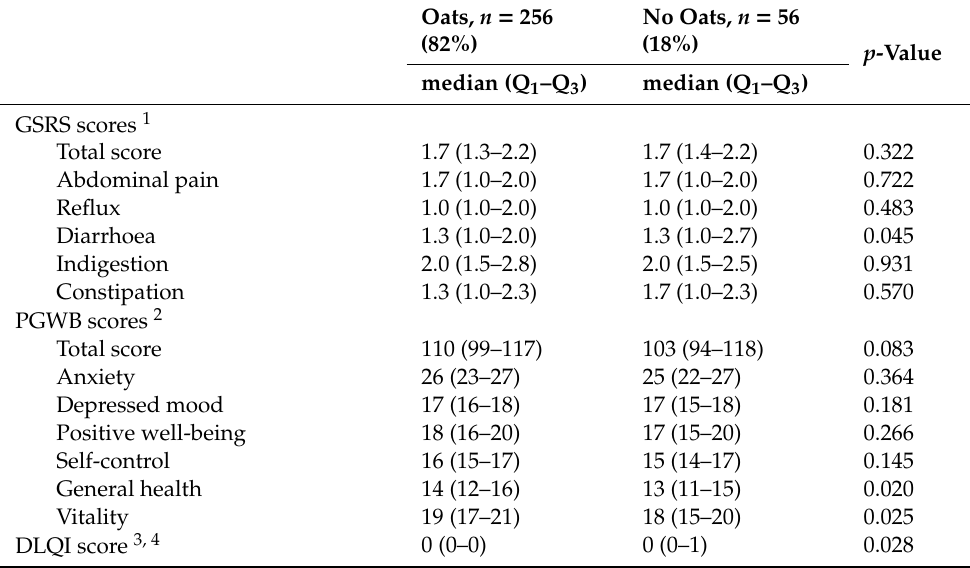
Table 3. Median values and quartiles (Q 1 –Q 3 ) for the Gastrointestinal Symptom Rating Scale (GSRS), Psychological General Well-Being (PGWB) and Dermatology Life Quality Index (DLQI) questionnaires’ total scores and sub-scores for the 312 dermatitis herpetiformis patients on a gluten-free diet with or without